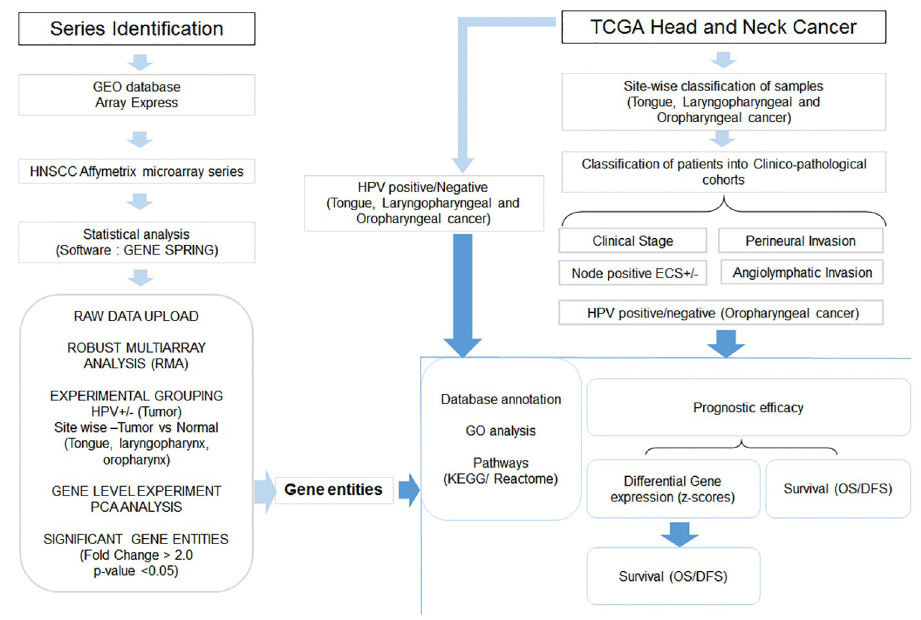
Fig 1. Over all work flow of site specific meta-analysis. Raw data (Affymetrix U133 Plus 2.0 microarray) of head and neck cancer series from publically available databases were downloaded and re-analyzed in Genespring statistical software. During analysis, post data upload onto the software, normalization (RMA) was carried out and samples grouped either into HPV positive/negative or based on sites (tongue, laryngopharyngeal and oropharyngeal cancer). In each site, further sample grouping was carried out into tumor and normal. Gene level experiment was performed in the software and PCA/clustering analysis was carried out to remove the discordant samples. Significant gene entities were identified (fold change > 2.0, p-value < 0.05) from each analysis/experiment. The annotation of the significant genes was carried out by TOPPFUN gene enrichment analysis (GO analysis/pathways). For validation, The Cancer Genome Atlas (TCGA) Head and Neck squamous cell carcinoma (HNSCC) cohort was classified based on HPV (HPV +/-) and site (tongue, laryngopharyngeal and oropharyngeal cancer). Patient cohorts in each site were further classified based on stage/pathological parameters and/or HPV. The significant gene entities identified from meta-analysis were validated in their respective cohorts; differential mRNA expression (z-score) and association with survival (OS/DFS) were the main